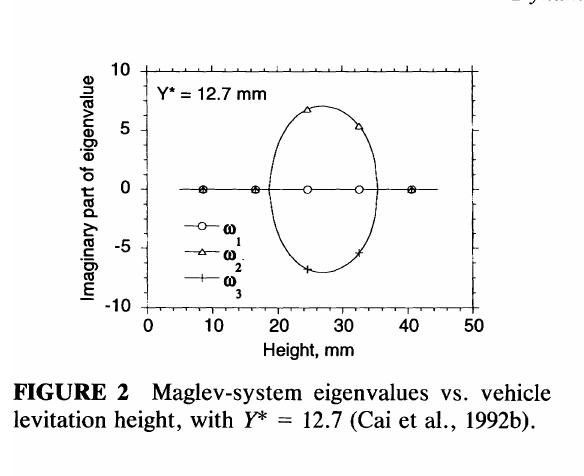
FIGURE 2 Maglev-system eigenvalues vs. vehicle levitation height, with Y* = 12.7 (Cai et aI., 1992b).